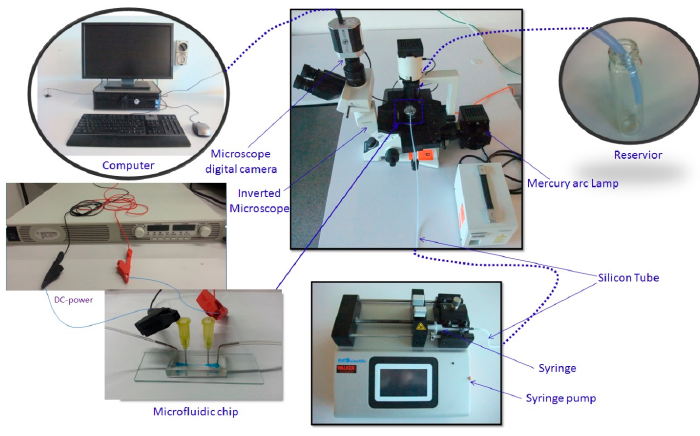
Figure 1. Experimental setup.